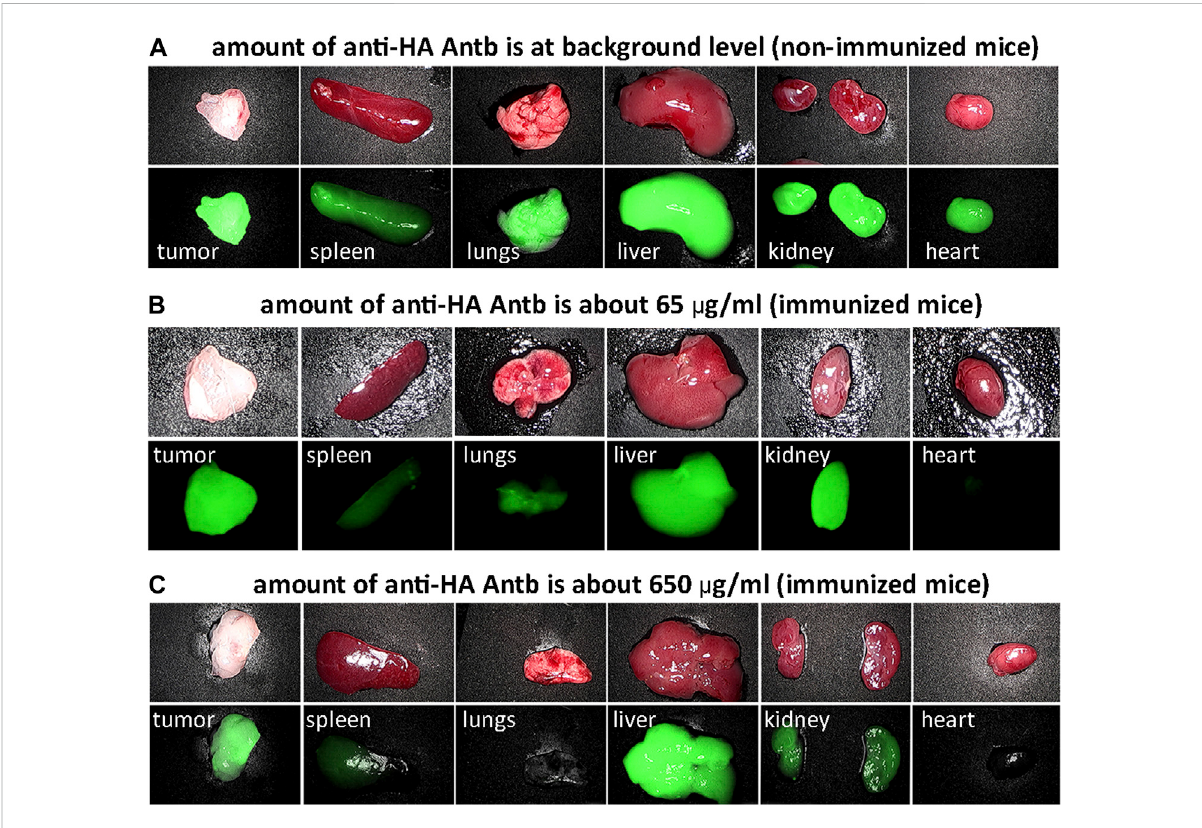
FIGURE 6 HA-pHLIP tumor targeting and biodistribution. Photos and NIR fl uorescent images of major organs collected 24-h after administration of HA- ICG-pHLIP tomicebearing4T1 fl anktumors:non-immunizedmicecontainingnoanti-HAantibodies (A) andimmunizedmicewithlow (B) andhigh titer of anti-HA antibodies (C)